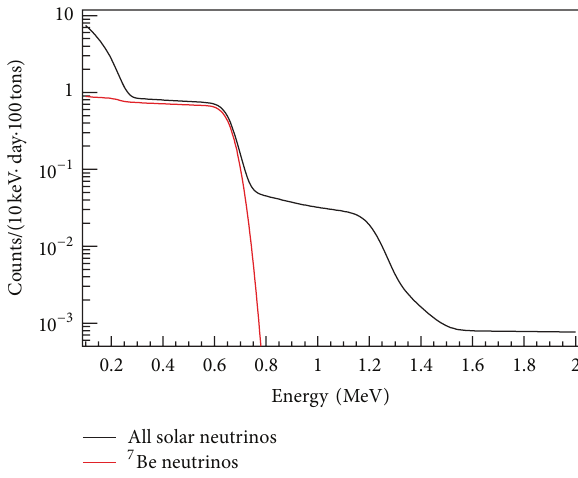
Figure 7: Neutrino spectra expected in Borexino (accounting for the detector’s energy resolution). The upper line represents the neutrino signal rate in Borexino according to the most recent predictions of the standard solar model [118] including neutrino oscillations with the LMA-MSW parameters. The lower line illus- trates the contribution due to 7 Be neutrinos. The pp neutrinos contribute to the spectrum below 0.3 MeV and the edge at 1.2MeV is due to pep neutrinos (from